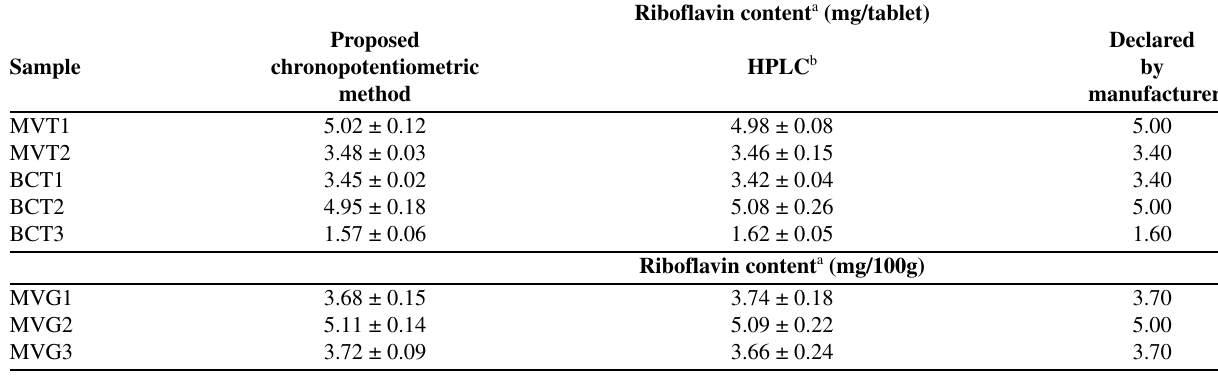
Table 3 . Riboflavin contents in pharmaceuticals obtained using proposed chronopotentiometric method and HPLC as reference method